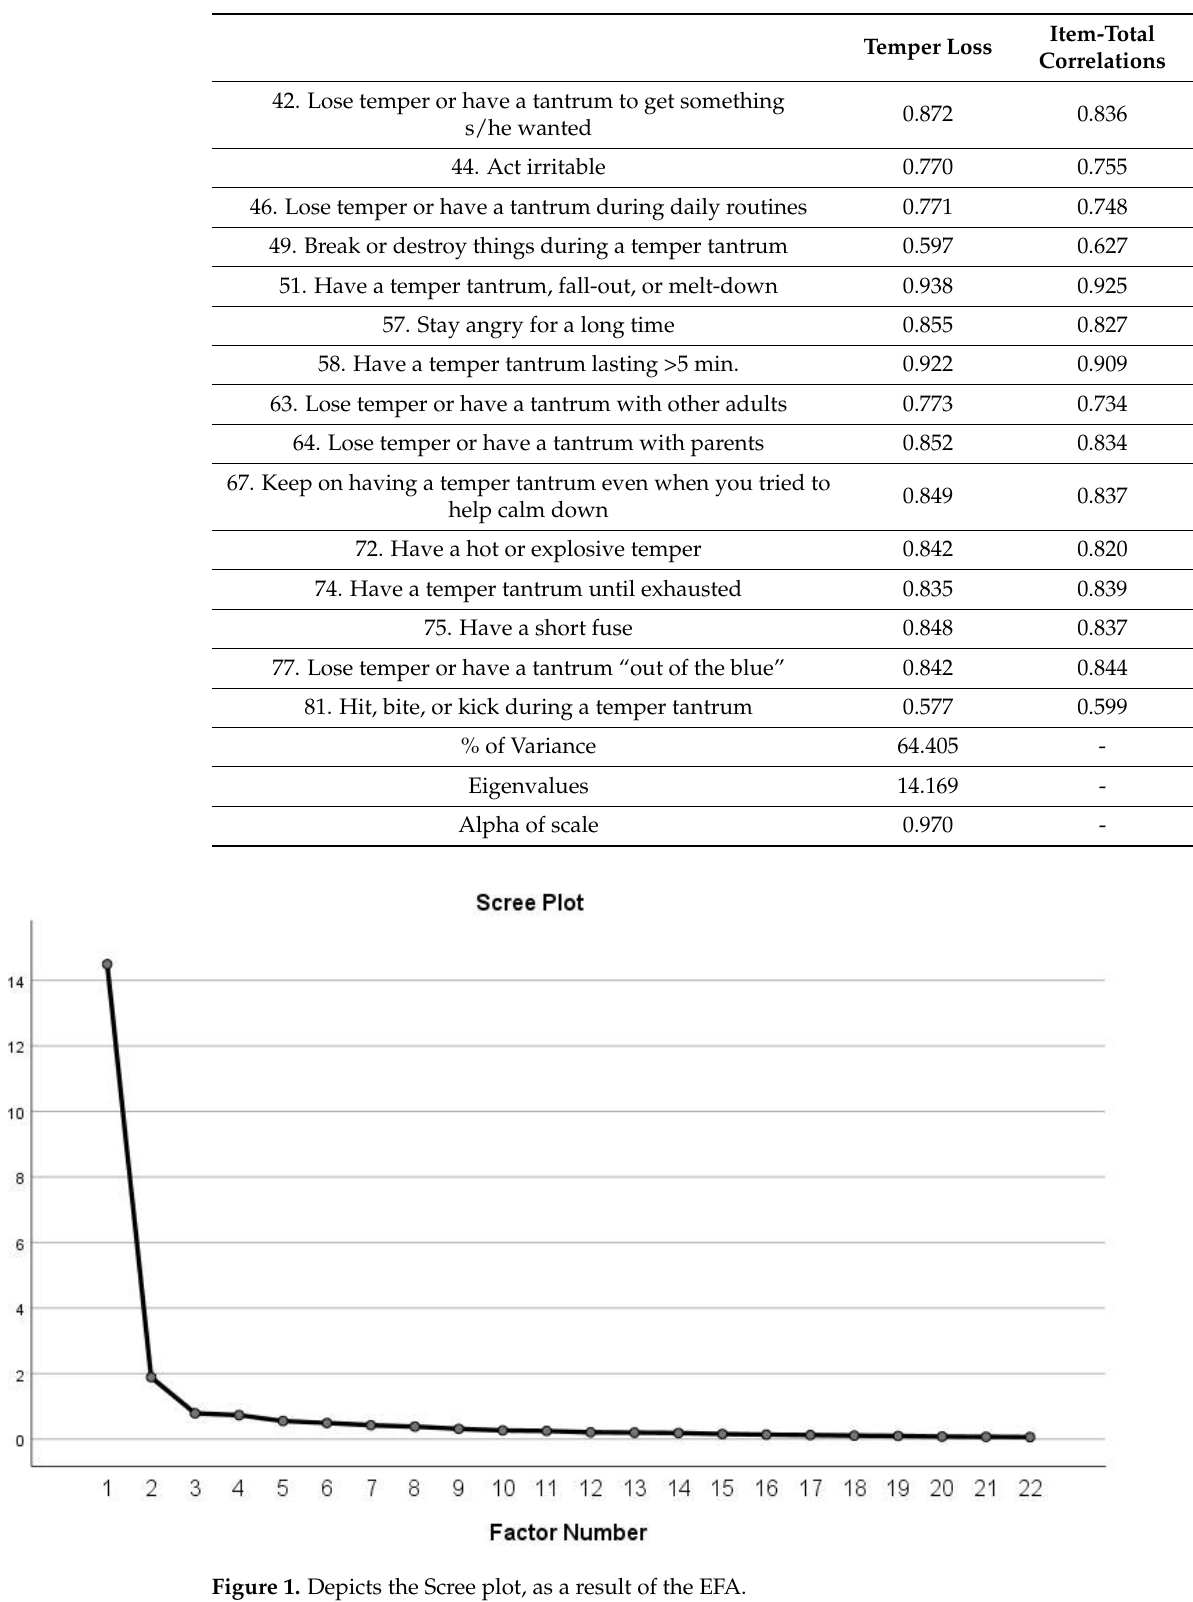
Figure 1. depicts the Scree plot, as a result of the EFA. Figure 1. Depicts the Scree plot, as a result of the EFA. Correlations between Temper loss and the seven subscales of the CBCL checklist are presented in Table 4. Overall, a strong positive correlation between the subscale of